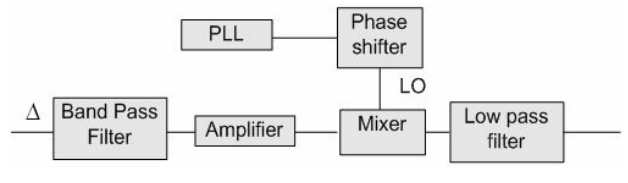
FIG. 14. (cid:1) channel signal processing.